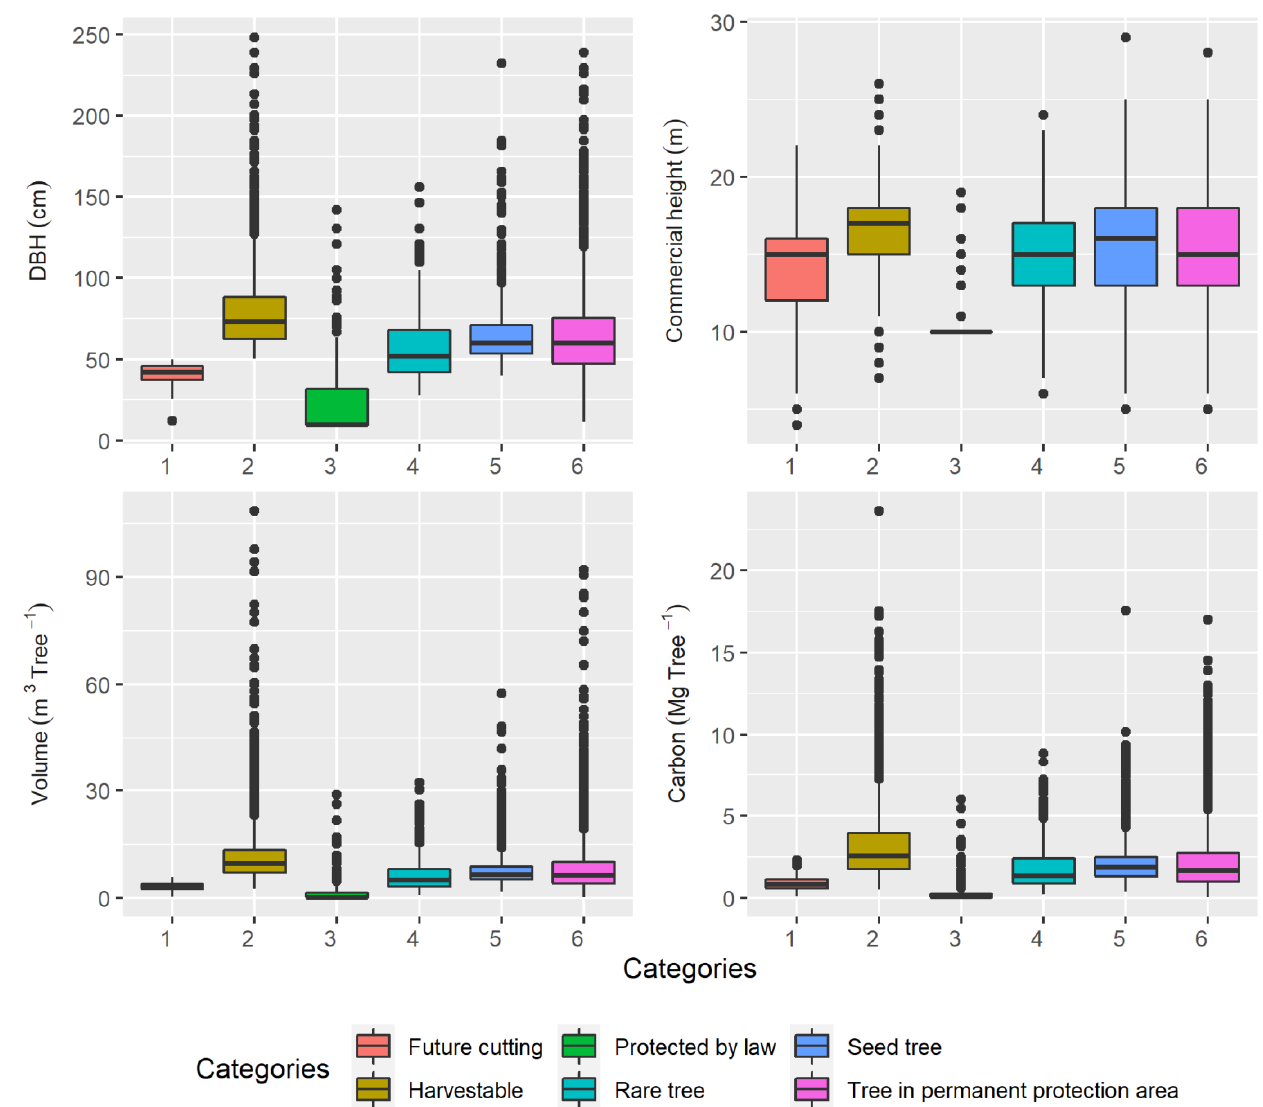
Figure 3. Distribution of dendrometric variables for each tree category in a managed forest in Brazil’s state of Acre. Boxes outline interquartile range, and vertical lines extend to 1.5 × interquartile range, with outliers individually marked. Note that volume and carbon values include stumps and crowns.